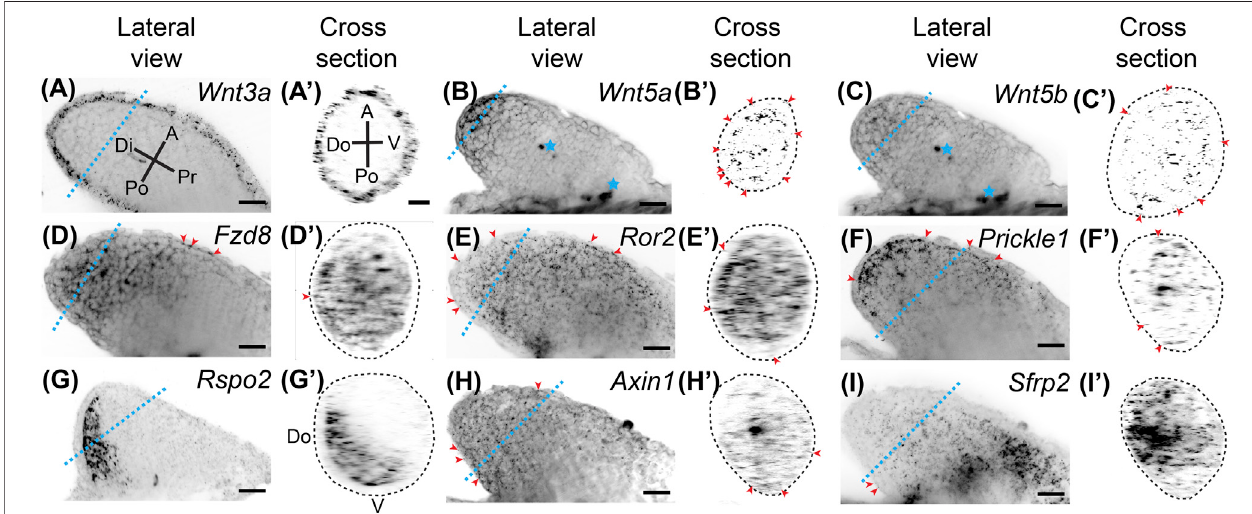
FIGURE 1 | Expression of Wnt signaling genes in stage 46 developing axolotl limb buds. (A) Coronal view of Wnt3a ligand expression in a Stage 46 limb bud showing broad expression throughout the epithelium. Di is distal, A is anterior, Pr is proximal, and Po is posterior. The blue dotted line indicates the plane shown in the crosssection. (A ′ ) Cross-sectionalviewofthelimbshownin (A) .Aisanterior,Visventral,Poisposterior,Doisdorsal.Noticethereisnodifferenceinexpressionbetween theanterior,posterior,dorsal,orventralaxes(APDV). (B) Theligand Wnt5a expressioninthelimbbud.Expressionisstronginthebasallayerofthedistalepithelium and distal mesenchyme. Blue stars indicate regions of non-speci fi c signal or auto fl uorescence of tissue, which was most often muscle in the fl ank of the embryo. (B 9 ) Cross-sectional area of Wnt5a limb. Red arrowheads indicate expression of Wnt5a in the epithelium around the entire circumference of the limb. The dotted lines in the cross-sectionalviewrepresentstheoutsideoftheepithelium. (C) Theligand Wnt5b expressionwasgenerallyweakinthedevelopinglimbbudandmainlymesenchymal. (C 9 ) Sparce Wnt5b expression in the mesenchyme and even less in the epithelium highlighted with red arrowheads. (D) The Wnt receptor Fzd8 expression in the limb bud. Broad mesenchymal expression was observed throughout the distal half of the limb bud. Red arrowheads indicate the few positive spots in the epithelium. (D 9 ) Cross-sectional view of the limb in (D) . Notice the expression of Fzd8 across the APDV axes. (E) Expression of the Wnt5a receptor, Ror2 . Expression was observed across all axes throughout the entire limb bud mesenchyme with very little expression in the epithelium, highlighted with red arrowheads. (E 9 ) Cross section of Ror2 expression showingthe strong expression along theAPDV axes. (F) Expressionofthedownstream target of Wnt5a , Prickle1 ,in the limb bud. Prickle1 mRNA dots were more concentrated distally and anteriorly. Some expression was also observed in the epithelium, highlighted with red arrowheads. (F 9 ) Cross-section of limb in (F) . (G) The alternative Wnt ligand, Rspo2 , showed completely mesenchymal expression primarily in the posterior region of the limb bud. (G 9 ) The cross-sectional view shows Rspo2 isexpressed dorsallyandposteriorlyinthemesenchyme. (H) TheWnttargetgene, Axin1 ,waslowlyexpressed throughoutthelimbbudinboththemesenchyme and epithelium. (H 9 ) Cross-section of Axin1 limb showing low, but broad expression. (I) The Wnt inhibitior, Sfrp2 , in the limb bud showing high expression, especially in theproximalportionsofthelimb. (I 9 ) Cross-sectionof Sfrp2 expressinglimbshowsexpressionacrosstheAPDVaxis,mainlyinthemesenchyme.Scalebarsinallpanels are 50